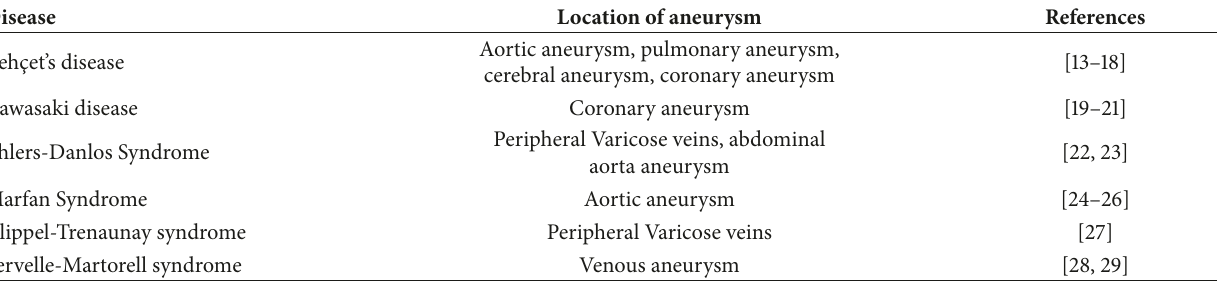
Table 1: Miscellaneous diseases associated with dilating vascular